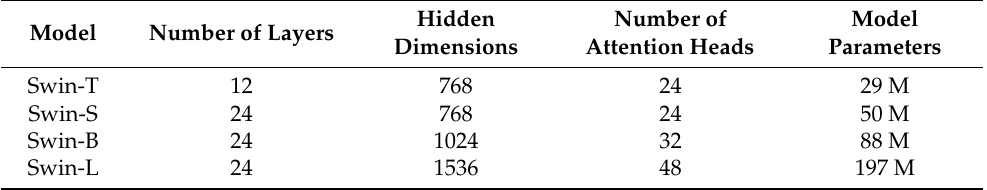
Table 1. Parameter statistics of tiny, small, base and large versions of the Swin Transformer.